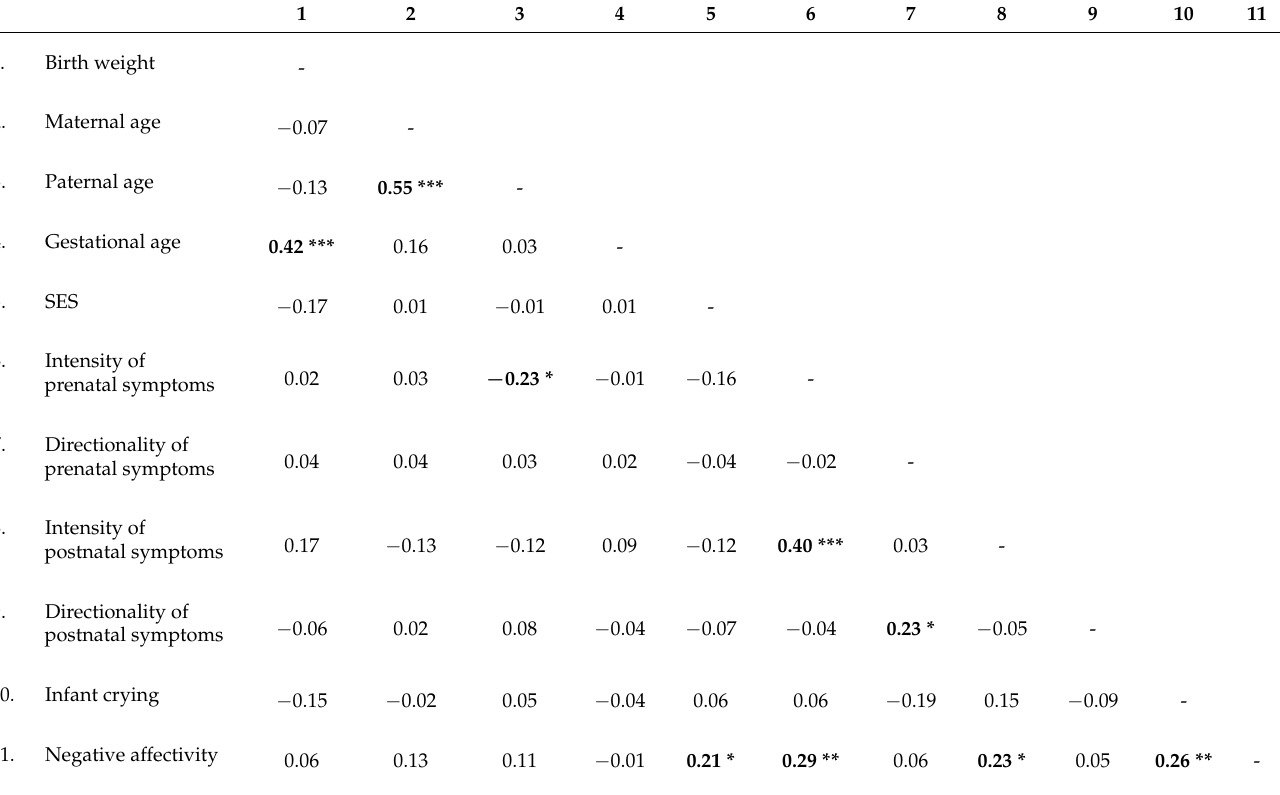
Table 2. Pearson correlations among sociodemographic variables, maternal prenatal and postnatal symptoms and infant outcomes.